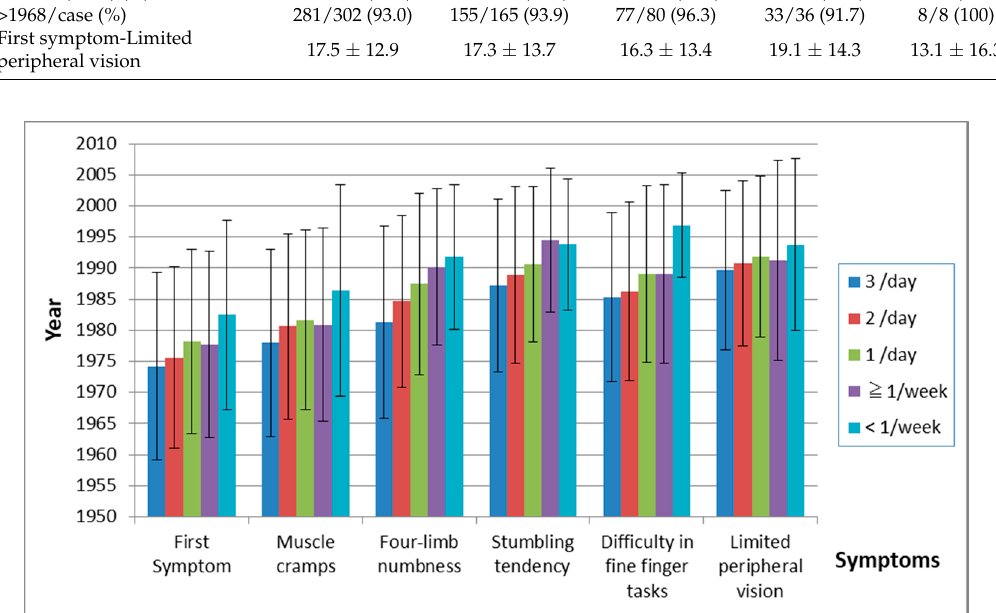
Figure 10. Years of each symptom after the first symptom. There was almost no relation between fish ingestion and duration from the first symptom to each following symptom, except for four-limb numbness. 3.5.3. Relations between Onset of Symptom and Scores of Signs and Symptoms The onset of symptoms was related to scores. When the onset year was earlier, the score became greater (Table 14). Table 14. Score of signs and onset of symptoms in each area. First Symptom